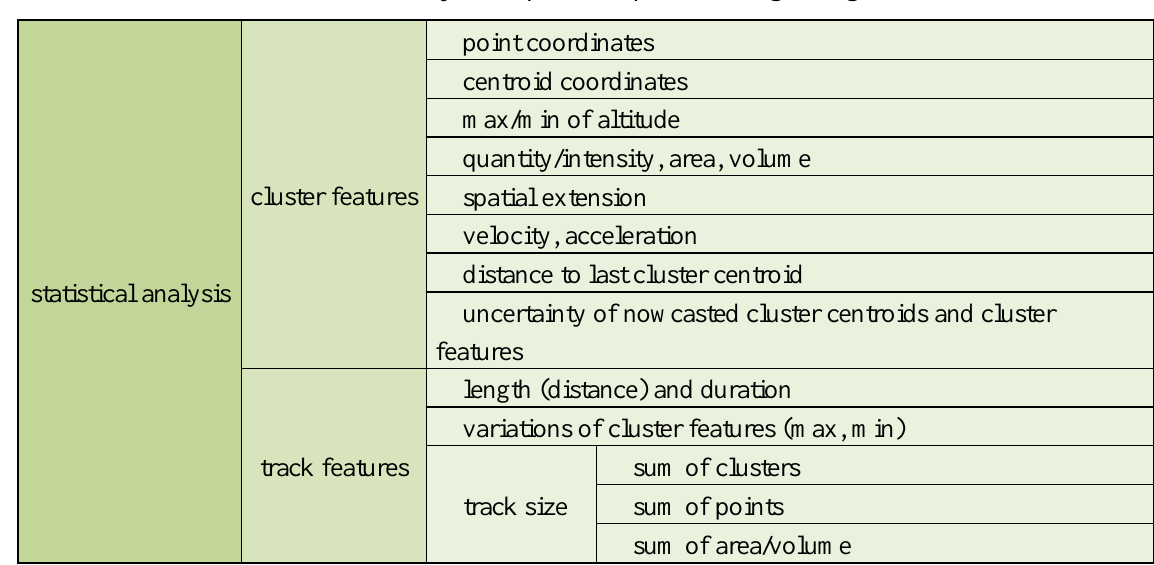
Table 4. Statistical analysis of past and predicted lightning